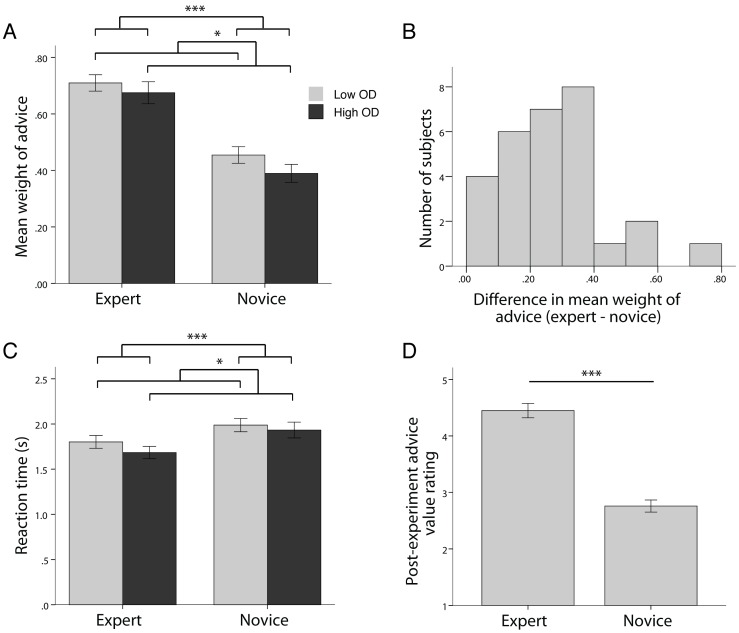
Behavioral data illustrating the utilization of advice.(A) Participants used expert advice more than novice advice (p<0.001). Important to note, all advice that participants received, from both experts and novices, was the actual price of the apartment (see Materials and Methods). Participants also used advice significantly more when the advice amount was close to their first estimate (low opinion difference) compared to when the advice was far from their first estimate (high opinion difference) (p = 0.017). (B) Histogram of individual differences in usage of advice with respect to expertise (mean expert WOA minus mean novice WOA). Participants demonstrated variability in their usage of advice from different sources. Notably however, all of the participants used expert advice qualitatively more than novice advice (no participants below zero). (C) Participants exhibited shorter reaction times when using expert advice than when using novice advice (p<0.001). They also responded more quickly when the opinion difference was high compared to when the opinion difference was low (p = 0.039). (D) After the experiment, participants rated the expert advice as being more valuable than the novice advice (scale from 1 =  low to 5 =  high; p<0.001). Error bars represent standard error of the mean. All analyses performed using repeated measures ANOVA unless otherwise indicated. OD  =  opinion difference.